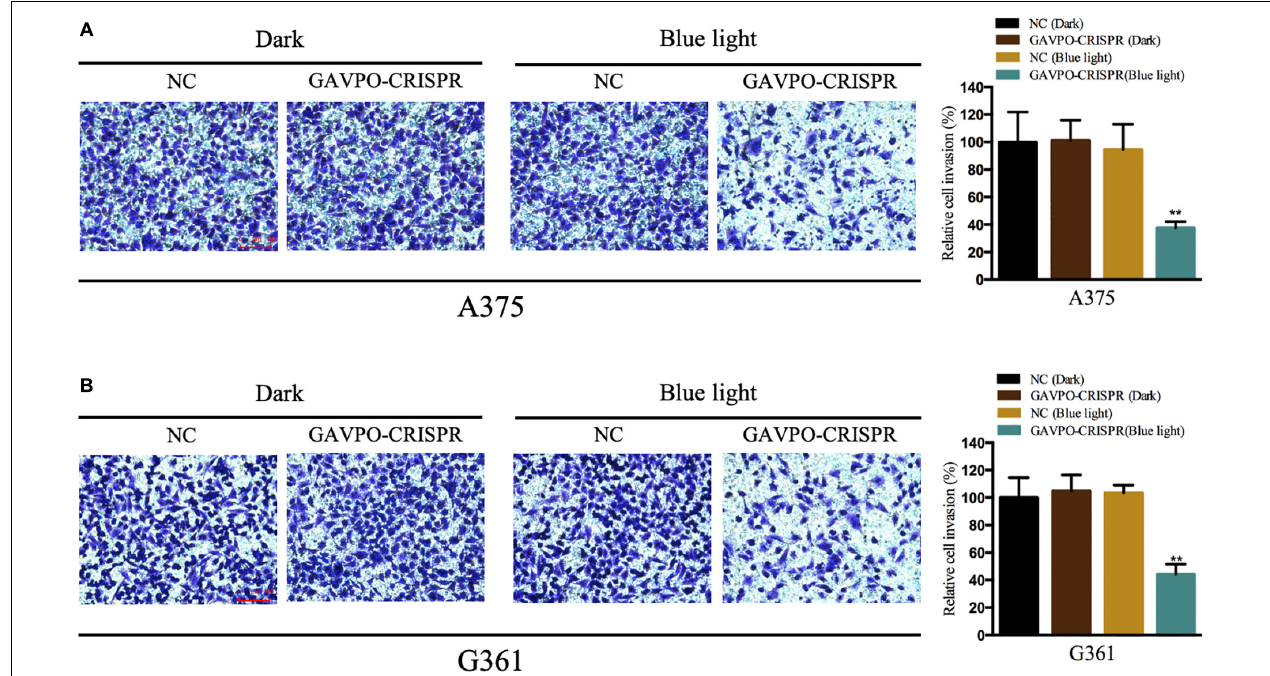
FIGURE 5 | Light-induced GAVPO-CRISPR system restricted melanoma cell invasion. (A) Transwell assay implicating the effect of light-induced GAVPO-CRISPR system under blue-light or dark conditions on cell invasion in A375 cells, compared to the negative control. (B) Transwell assay representing the effect of light-induced GAVPO-CRISPR system under blue-light or dark conditions on cell invasion in G361 cells, compared to the negative control. Data are presented as the means ± SD from at least three biological replicates. (* P < 0.05, ** P < 0.01, *** P <